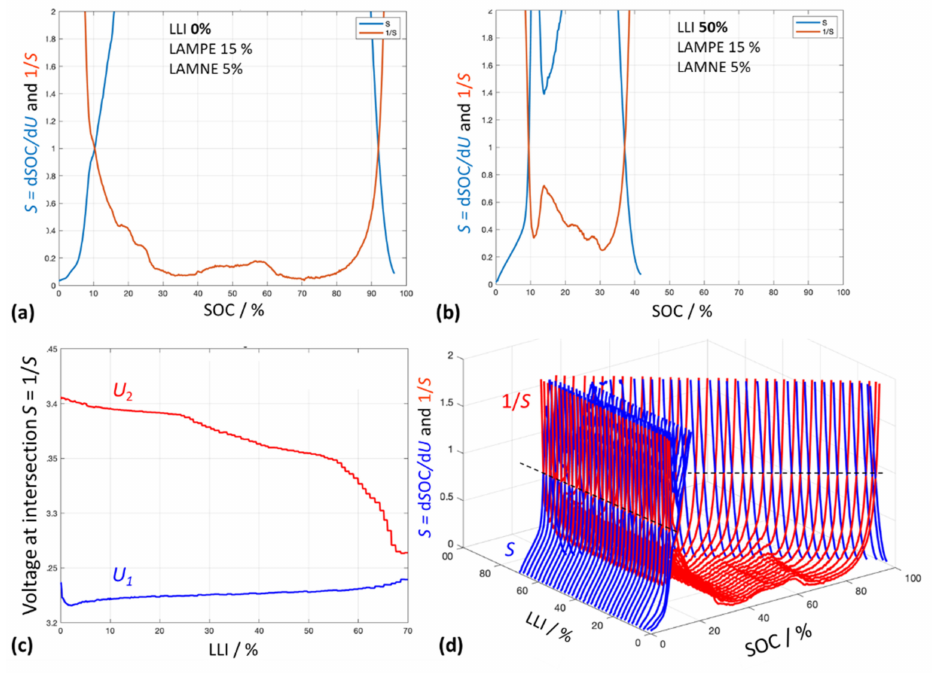
Figure 8. Application of the intersection method (this paper) to synthetic data from [26] for lithium iron phosphate chemistry. Here: loss of lithium-ion inventory (LLI) with constant loss of active material at the positive electrode (LAMPE) and the negative electrode (LAMNE). ( a ) Example curve “new” at the beginning of lithium loss, ( b ) “old” at 50% lithium loss versus the absolute state-of- charge with respect to the initial system (here: normalized capacity). The unit of S is V − 1 , the unit of 1/ S is V. ( c ) Change of voltage window during aging: U 1 and U 2 are the lower and the upper intersection points at S = 1/ S = 1. ( d ) Intersection criterion for all states of lithium loss between 0% and